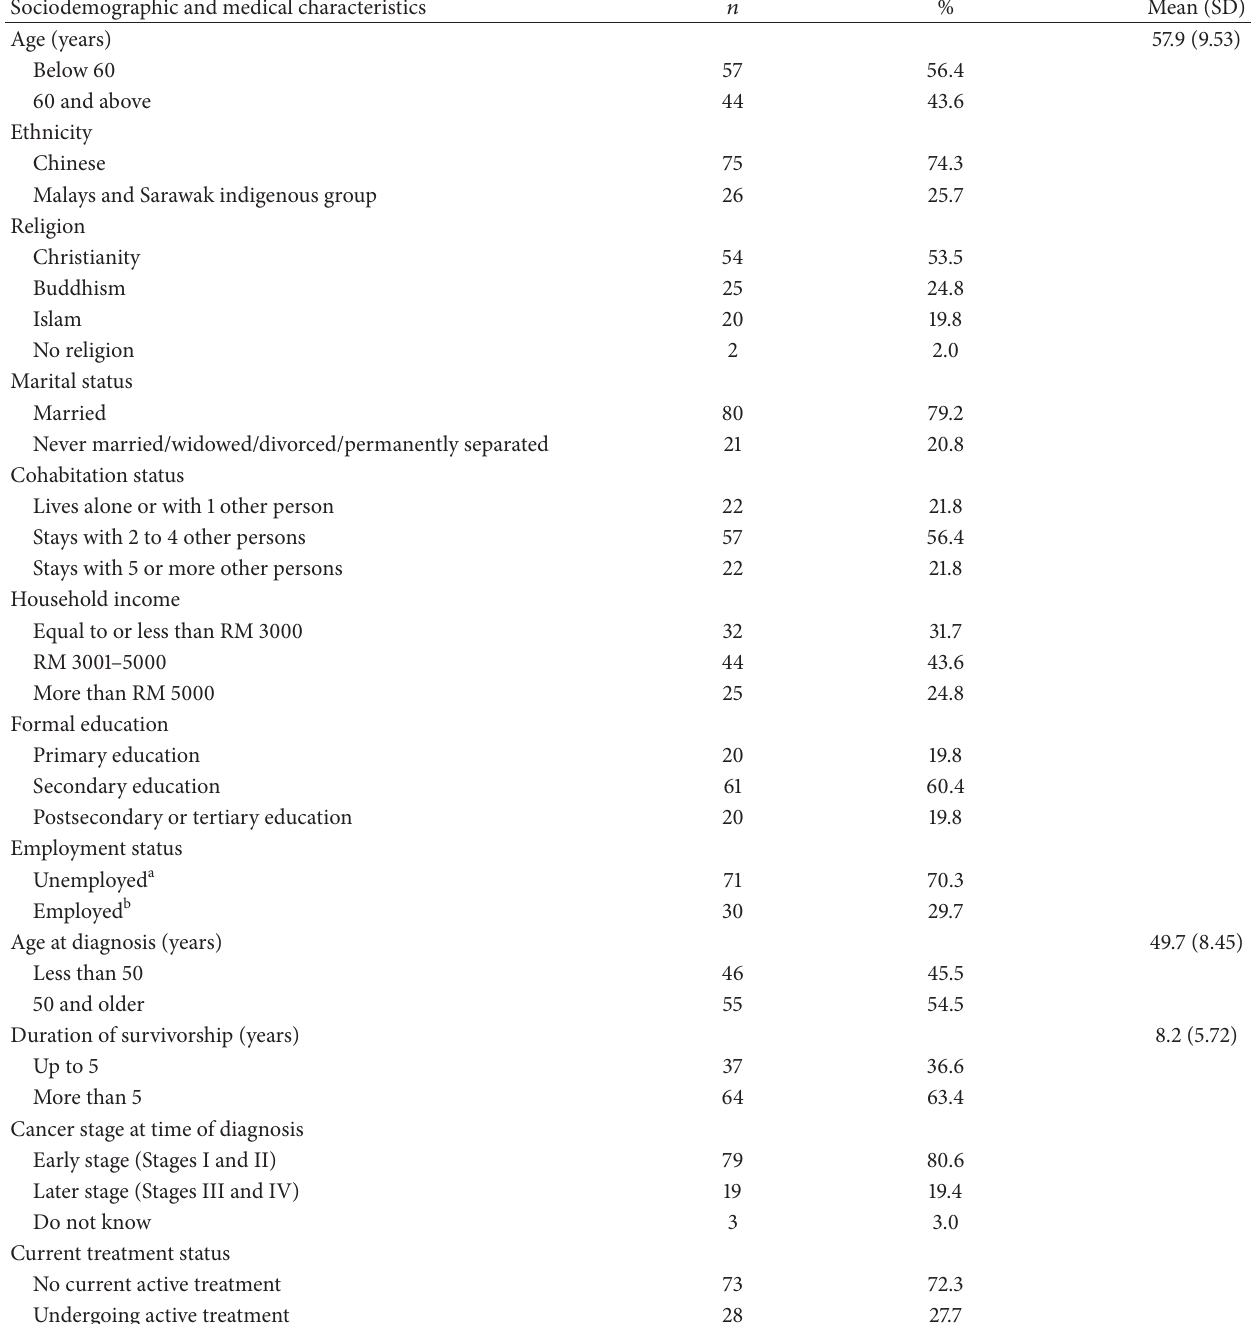
Table 1: Sociodemographic and medical characteristics of respondents ( 𝑁 = 101